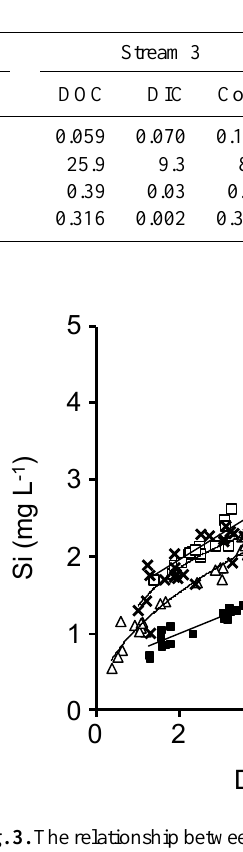
Table 3. Time series analyses (fitted trend and seasonal component) for stream 3 (2000–2006) and 6 (1982–2010). Here, MAPE is mean absolute percentage error, MAD is mean absolute deviation, MSD is mean square deviation, and Cond is conductivity. Yearly trends are given as mgCL − 1 (DOC and DIC) or mSm − 2 (conductivity).